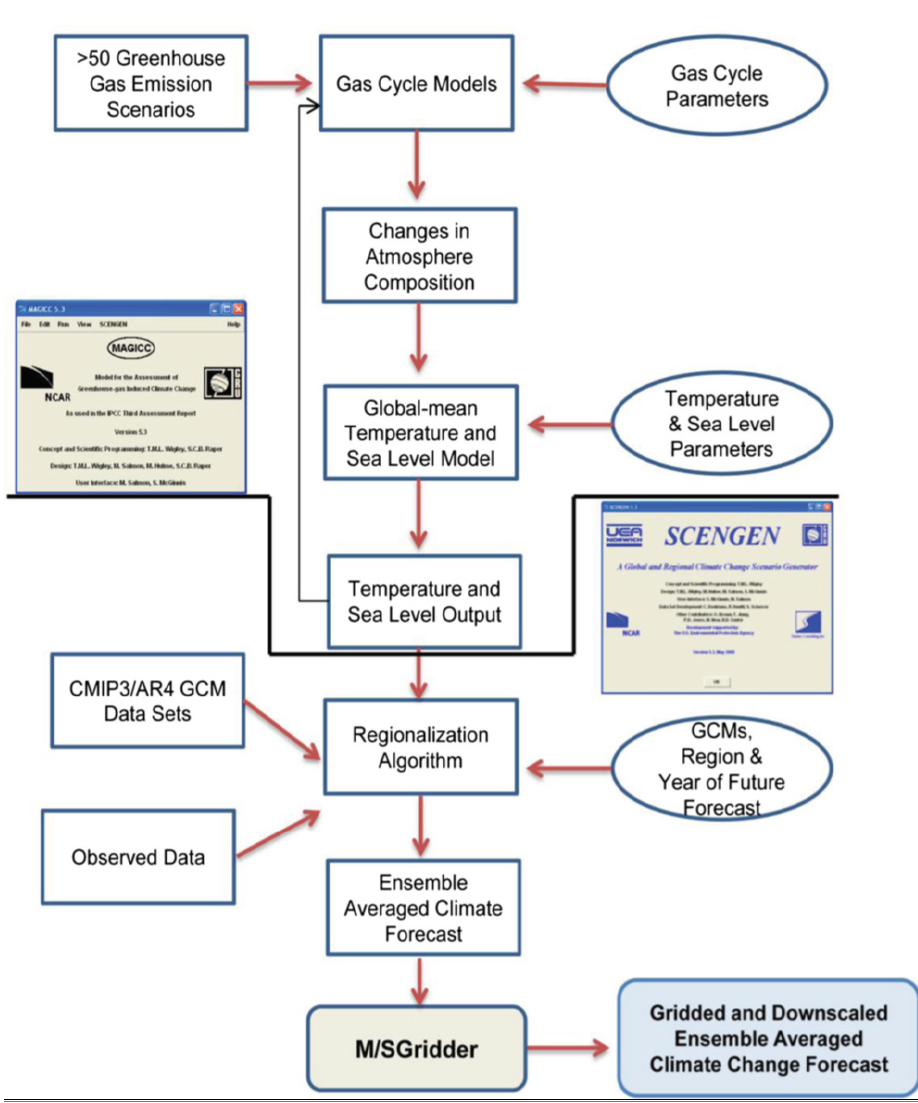
Figure 2. Structure and flow of the MAGICC/SCENGEN software. Elliptical shapes are used to highlight user defined model parameters, Fordham et al. doi:10.1111/j.1600-0587.2011.07398.x. [20].